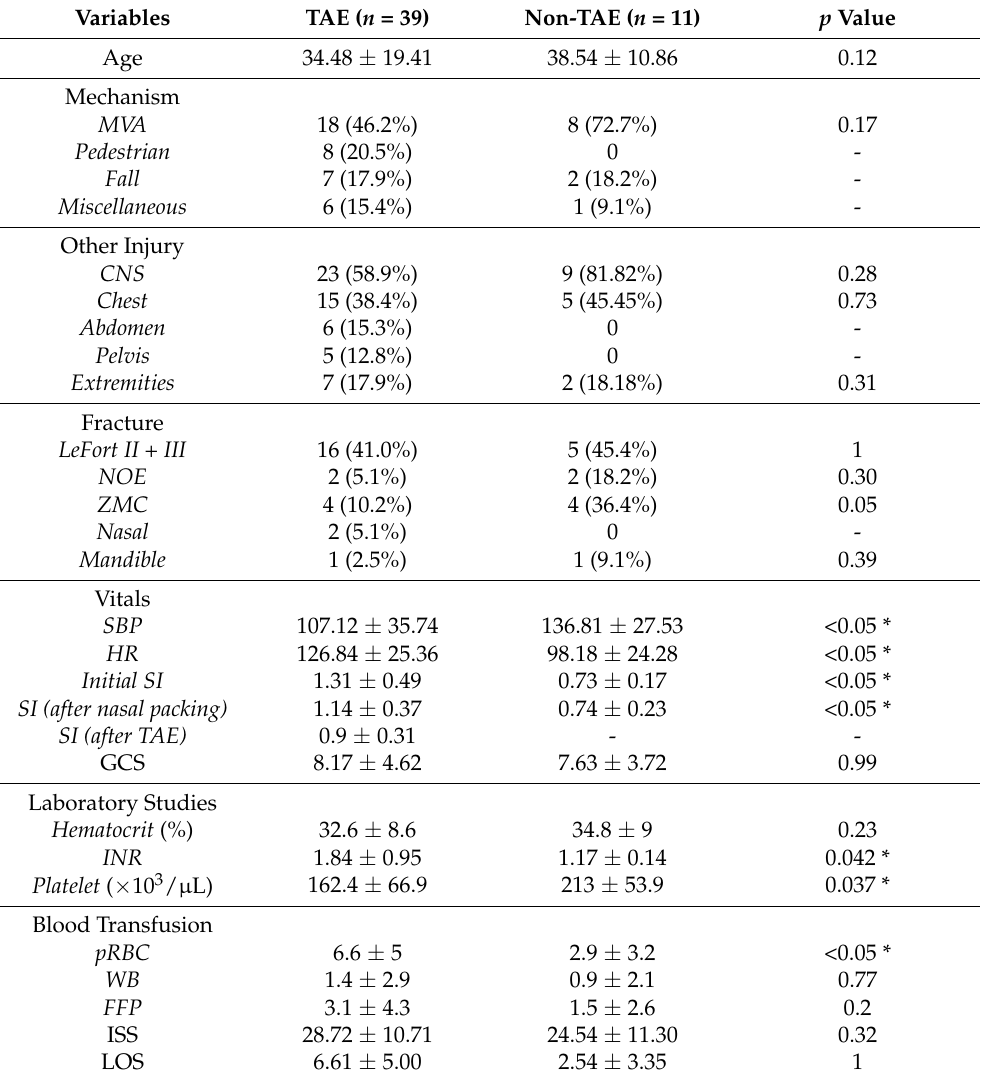
Table 1. Demographics of patients with post-traumatic life-threatening oronasal bleeding between angiographic hemostasis and non-angiographic hemostasis